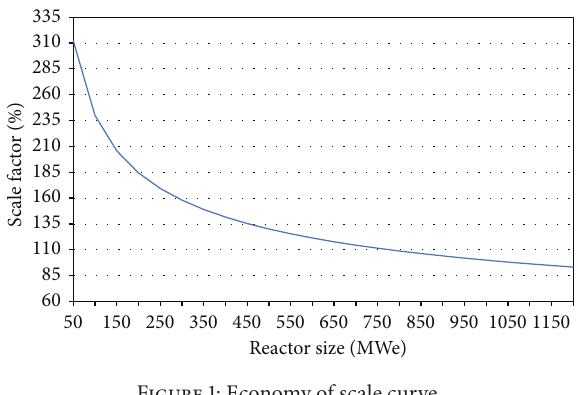
Figure2:ModularizationfactordependingontheNPPsizeinterms of output